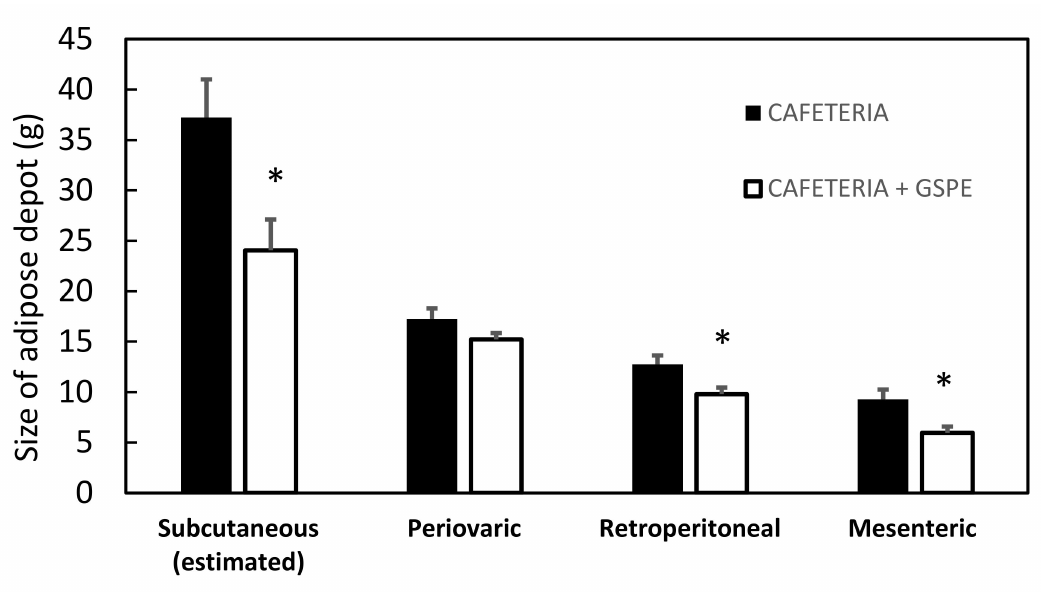
Figure 2. GSPE e ff ects on white adipose depots in the short cafeteria study. Adipose depots were obtained at the end of the treatment and each depot was weighed. Rats were treated with 0.5 g / Kg BW for the first 10 days, and then they were put on a chow diet for 18 days and a cafeteria diet for 35 days. The black column indicates animals not treated with GSPE. The white column indicates animals treated with 0.5 g / Kg BW of GSPE for the first 10 days of treatment. The data are the mean ± standard error of the mean (S.E.M.) (n = 7). Statistical di ff erences identified by t -test are defined by * when p < 0.05 between treatments. Table 2. GSPE e ff ects on mRNA levels of white adipose depots in the short cafeteria study.